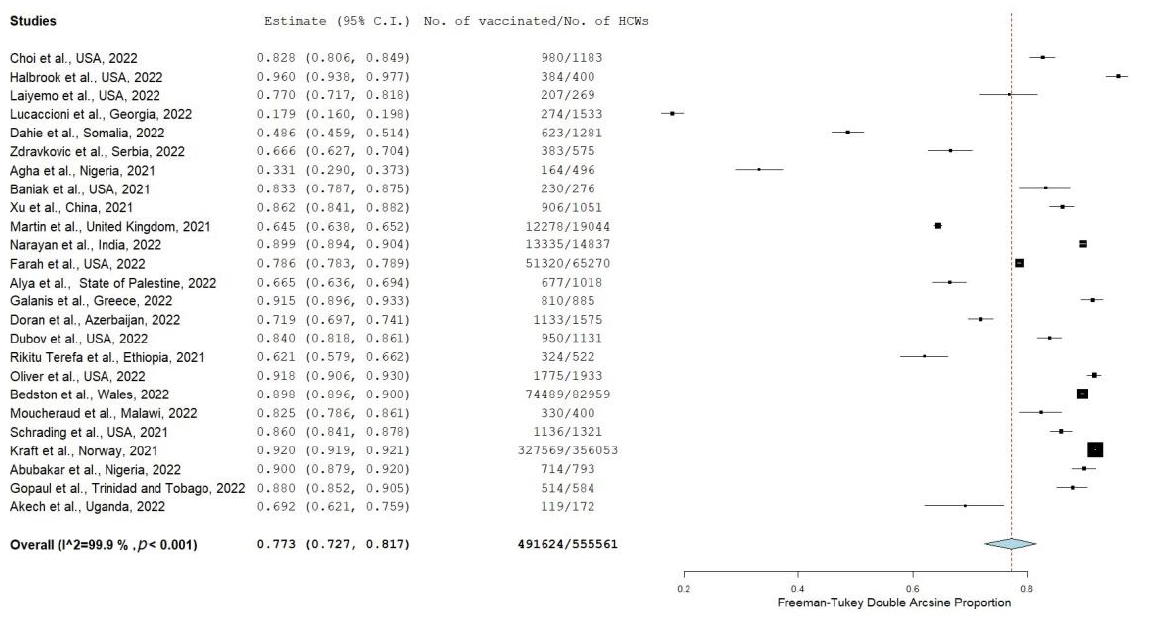
Figure 2. Forest plot of healthcare workers vaccinated against COVID-19 [32–56]. Vaccine uptake for studies that were conducted in North America (85.6% (95% CI: 80.5–90.0%), I2 = 98.49) was higher than the proportion for studies that were conducted in Asia (79.5% (95% CI: 66.2–90.2%), I2 = 99.5), Europe (72.8% (95% CI: 62.2–82.2%), I2 = 99.9), and Africa (65.6% (95% CI: 45.6–83.0%), I2 = 99.3) (Figure 3). We did not find